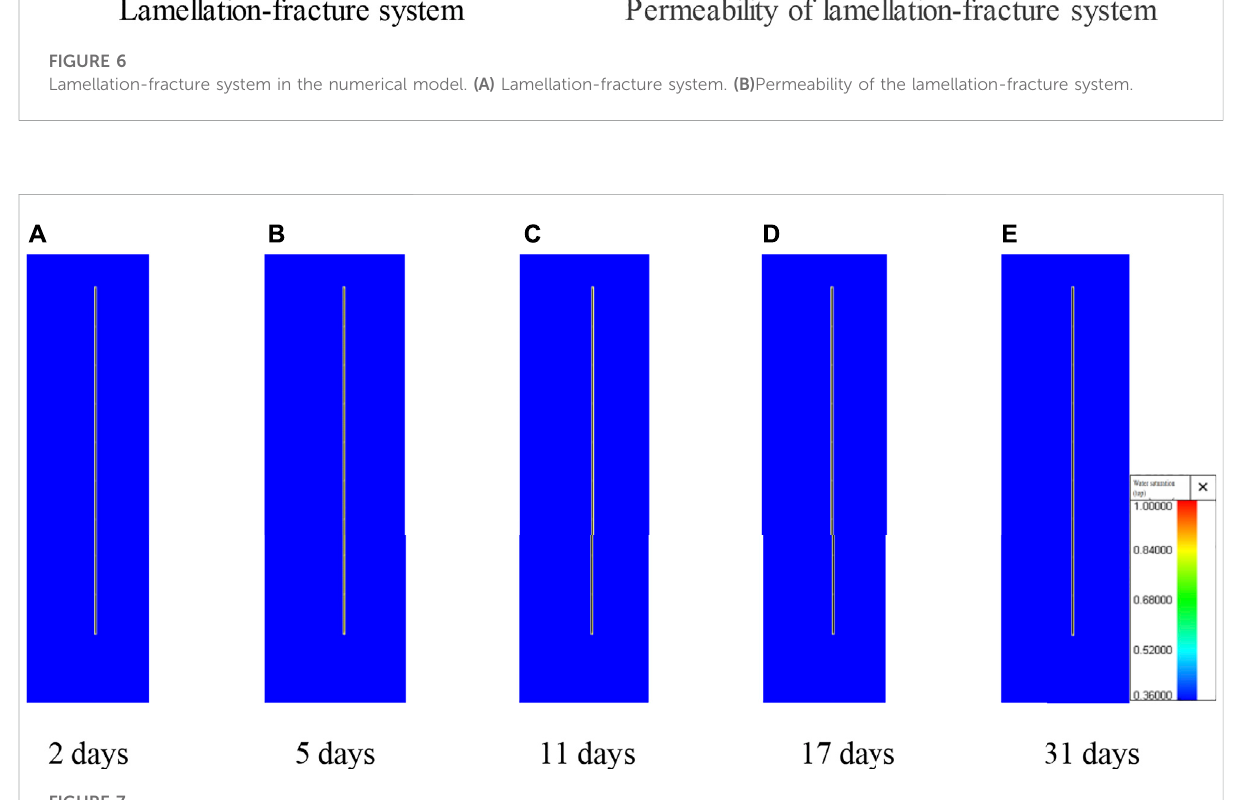
FIGURE 7 Water saturation fi eld of the shale matrix system during the shut-in period. (A) 2 days, (B) 5 days, (C) 11 days, (D) 17 days, and (E) 31